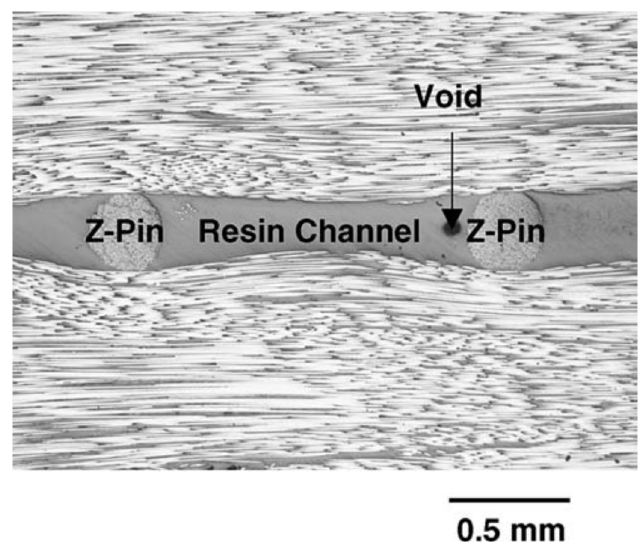
Figure 5. Resin channel along a row of closely spaced z-Pins [11].